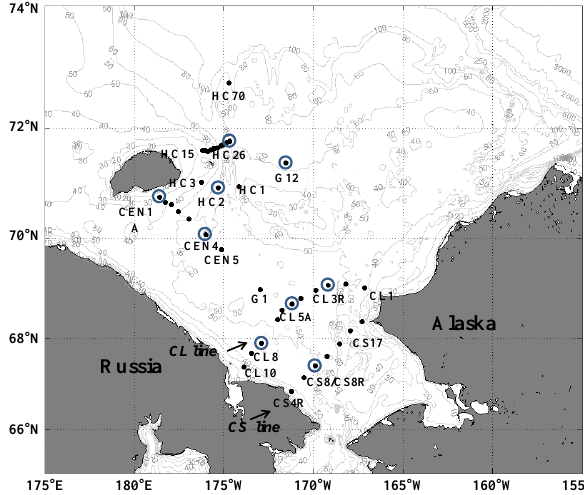
Figure 1. Locations of sampling stations during the 2012 RUSALCA expedition in the Chukchi Sea. The primary production rates were measured at the stations identified by blue circles. CS8R represents a revisit to station